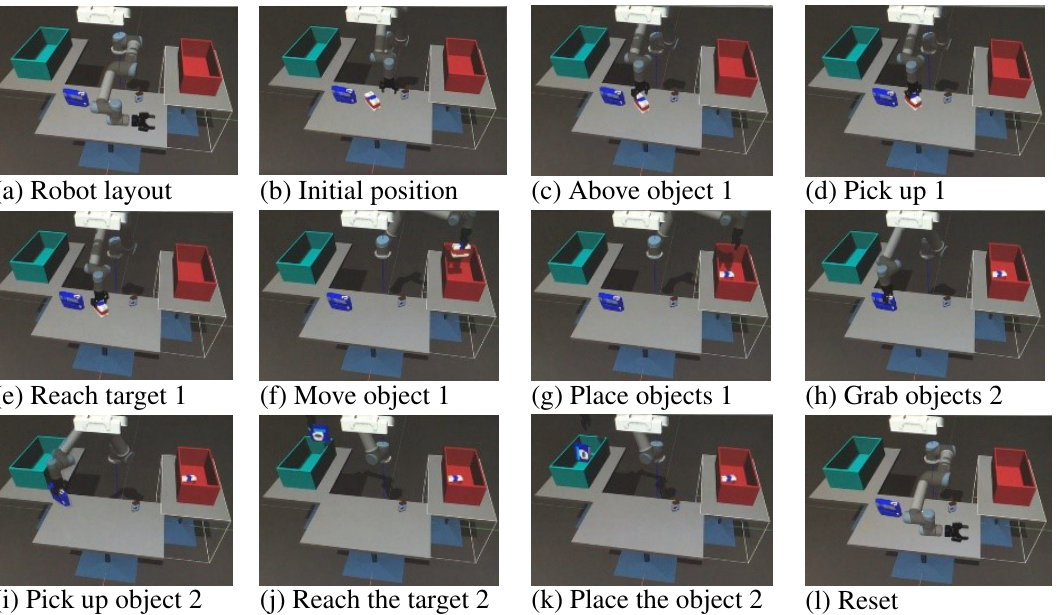
Fig. 3 UR5 robotic arm grasping simulation experiment.